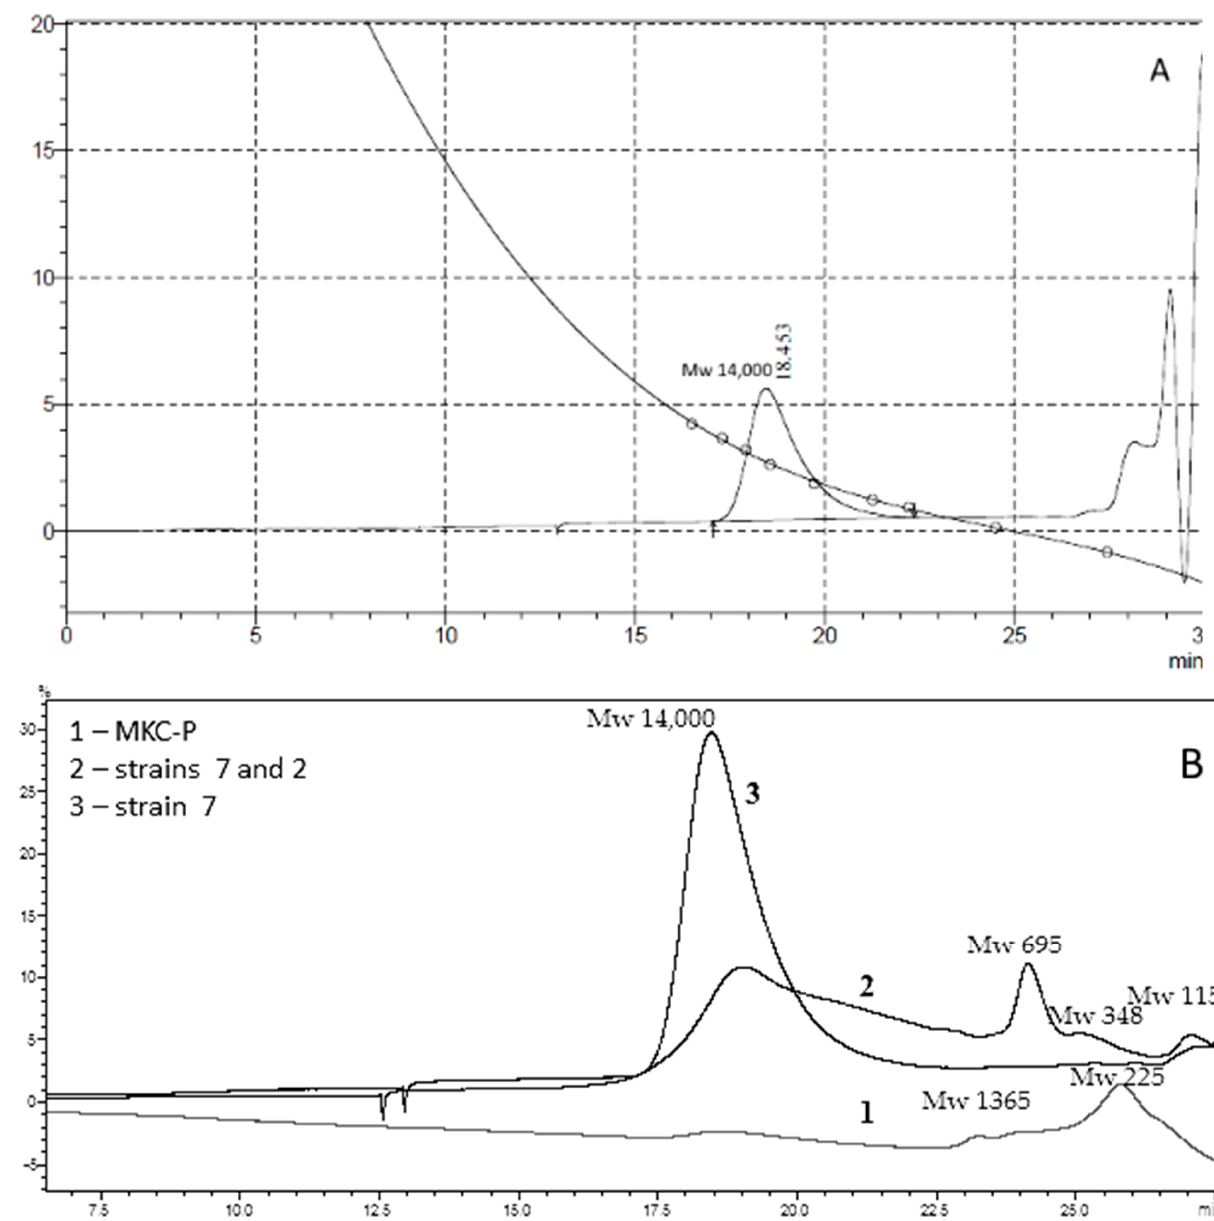
Figure 4. GPC elution pattern of PCL degradation intermediates on 48 h of cultivation. ( A ), Control—pure PCL; ( B ), 1, MKC-P; 2, co-culture of B. thermoruber strain 7 and A. thermoaerophilus strain 2; 3, B. thermoruber strain 7.